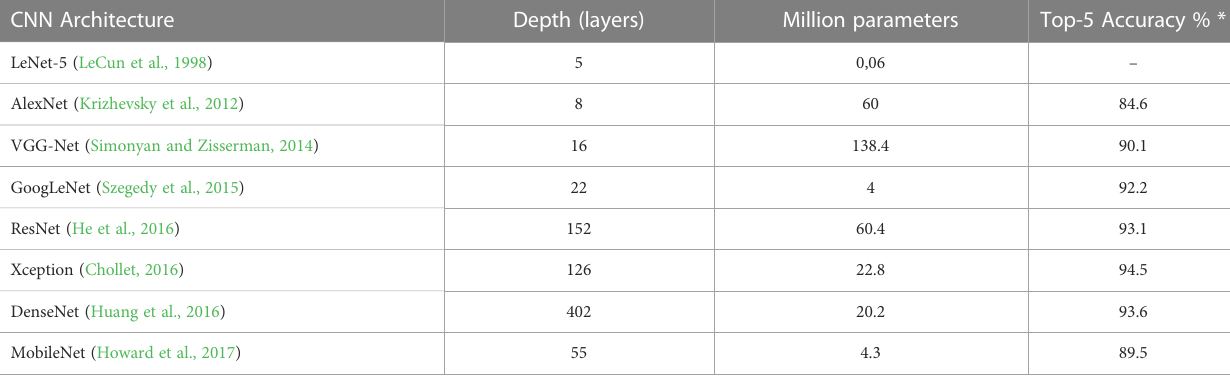
TABLE 1 Characteristics of the deep learning architectures most commonly used in crop